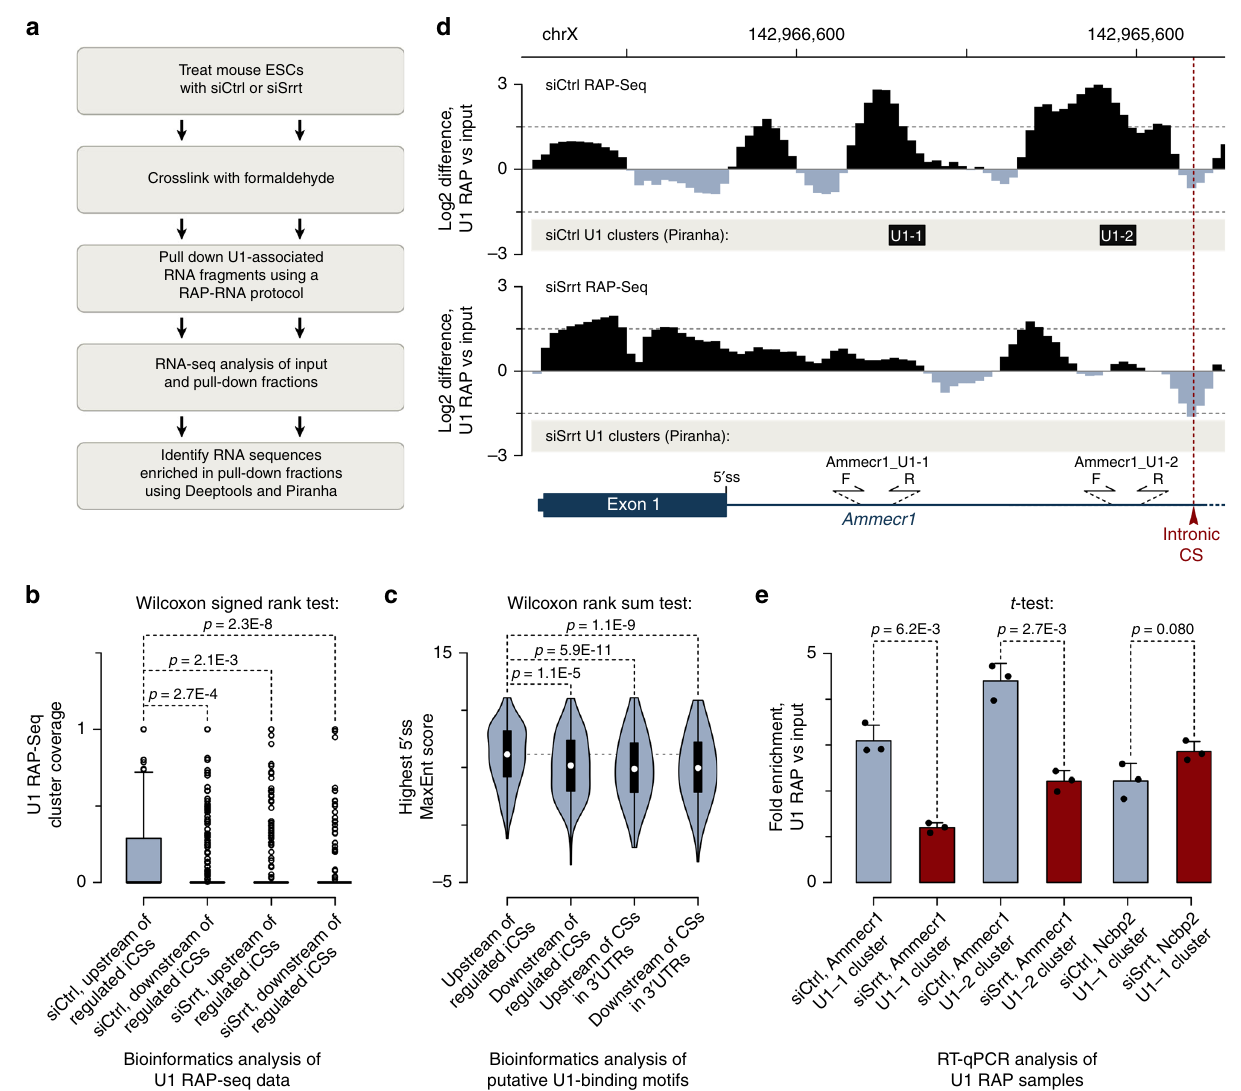
Fig. 5 Srrt stimulates U1-binding upstream of CSs in fi rst introns. a Outline of the U1 RAP-Seq experiment. b Boxplot of U1 RAP-Seq cluster coverage showing stronger binding of U1 snRNP in a 250-nt window upstream of Srrt-regulated iCSs than in a similarly sized window downstream of these sites in siCtrl-treated samples. Note that U1-binding ef fi ciency is diminished following Srrt knockdown. P values were calculated using a two-tailed Wilcoxon signed rank test. The box bounds represent the fi rst and the third quartiles and the thick black lines at the bottom of the boxes show the medians. Since the distributions are skewed towards 0, only the top whisker is evident, extending to 1.5× of the range between the third and the fi rst quartiles (interquartile range). Open circles, outliers. c Consistent with the data in b , the 250-nt window upstream of Srrt-repressed CSs tends to contain stronger putative U1- binding motifs (measured as the maximum 5 ′ ss MaxEnt value) than the 250-nt downstream window or similarly sized windows abutting CSs in the corresponding 3 ′ UTRs. P values were calculated using a two-tailed Wilcoxon rank sum test. Violin plot outlines show kernel density estimates of probability densities; open circles, the medians; and bounds of the black boxes, the fi rst and the third quartiles. Whiskers extend from the fi rst and the third quartile to the lowest and highest data points or, if there are outliers, 1.5× of the interquartile range. b , c iCSs were considered regulated if they were upregulated ≥ 2-fold, FDR < 0.05 and their host gene was downregulated ≥ 1.5-fold, FDR < 0.05 in response to siSrrt. d Input-normalized RAP-Seq coverage pro fi le and Piranha clusters (U1-1 and U1-2) showing strong interaction of U1 snRNP with at least two intronic positions preceding the Srrt-repressed CS in the Ammecr1 gene in the siCtrl- but not siSrrt-treated ESCs. Sequences enriched in RAP-Seq vs input are shown in black and those depleted are in gray. Primers used in the RT-qPCR validation experiment in e are shown at the bottom. e RT-qPCR validation of RAP-Seq results using primer pairs matching U1 Piranha clusters in b and Supplementary Fig. 11e. Note that input-normalized signals are signi fi cantly higher in siCtrl U1 RAP samples than in their siSrrt-treated counterparts for the two regulated Ammecr1 clusters but not for a control cluster in the Ncbp2 pre-mRNA. Data were averaged from three experiments ± SD and compared by a two-tailed t -test. Source data are provided as a Source Data fi